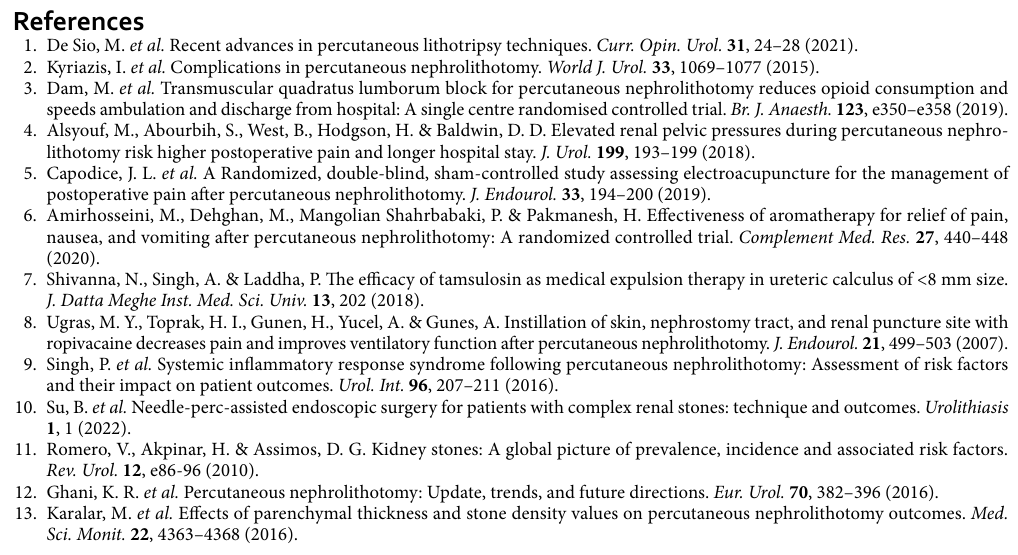
Table 2. Risk factors for moderate-to-severe postoperative pain in patients with PCNL.